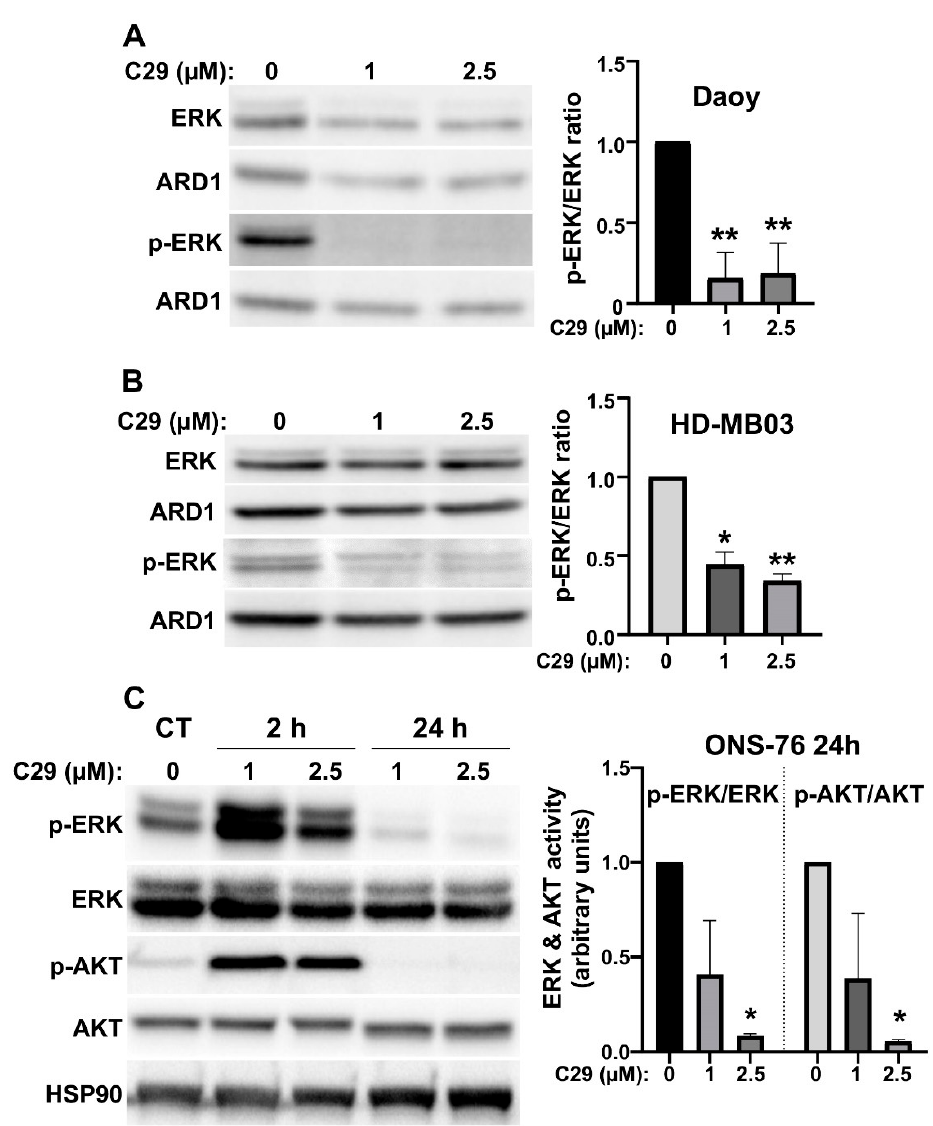
Figure 5. C29 inhibits signalling pathway that stimulates in cell proliferation and survival. ( A – C ). Daoy ( A ), HD-MB03 ( B ), and ONS-76 ( C ) cells were treated with C29 (1 or 2.5 µM) for 2 h ( A – C ) or 24 h ( C ), n = 3. The expression of p- ERK and p-AKT, relative to ERK and AKT, (respectively) was used to describe the relative activation of the pathways. ARD1 and HSP90 were used as loading controls. Statistics were performed using Student t -test for two comparisons only or ANOVA test for multiple comparisons. * p < 0.05, ** p < 0.01.